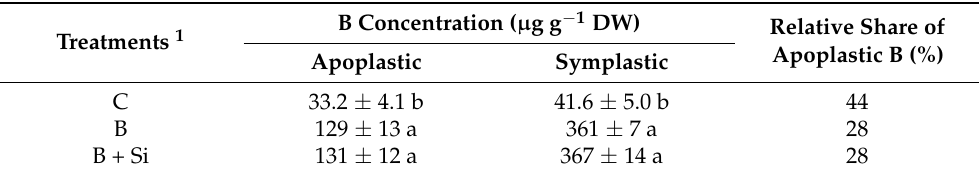
Table 2. Apoplastic and symplastic concentrations and relative apoplastic share of B in the youngest fully expanded sunflower